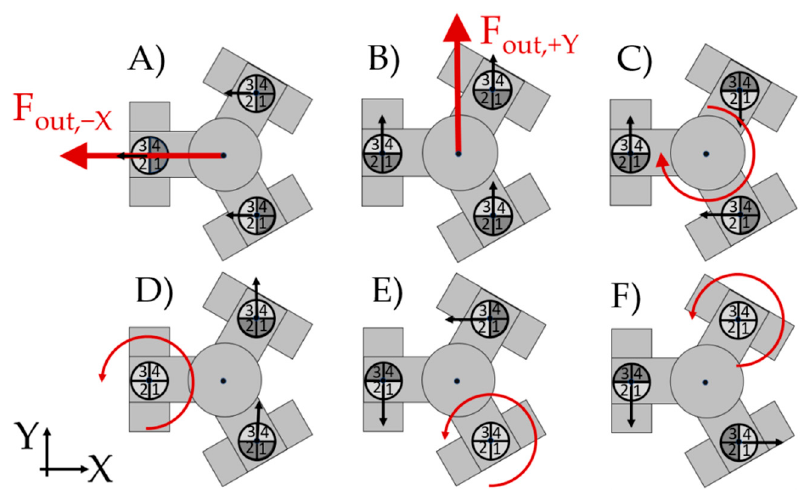
Figure 3. Motion directions of the planar motor drive platform (bottom view).